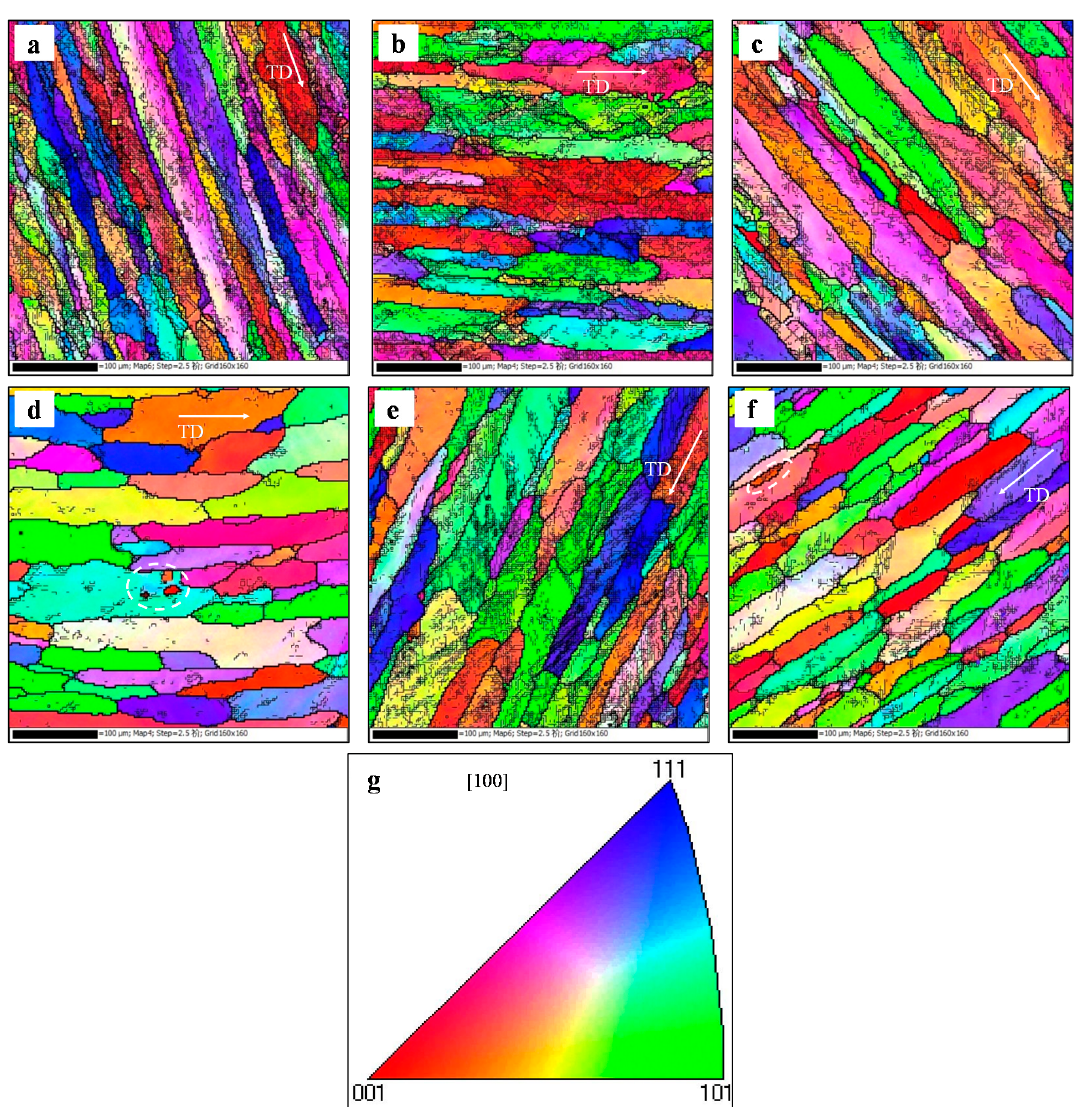
. ε = 0.0003 s − 1 ; ( e ) T = 200 ◦ C,